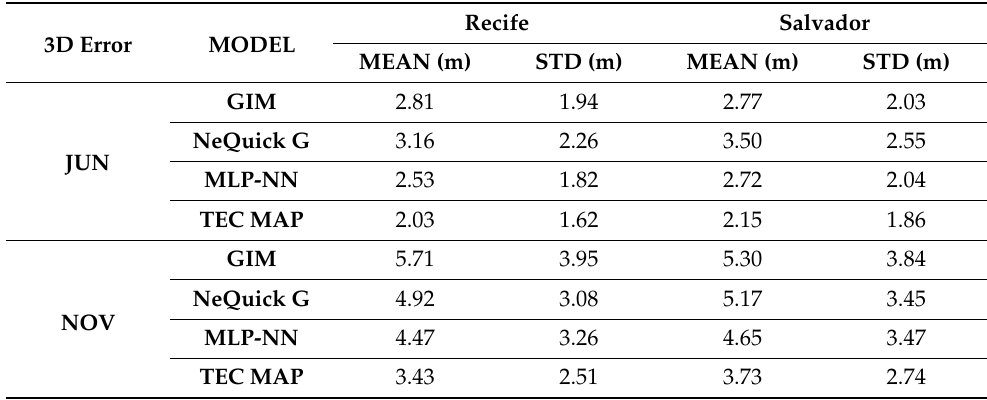
Table 4. Average and standard deviation for 3D error during the months of June and November in Recife and Salvador during